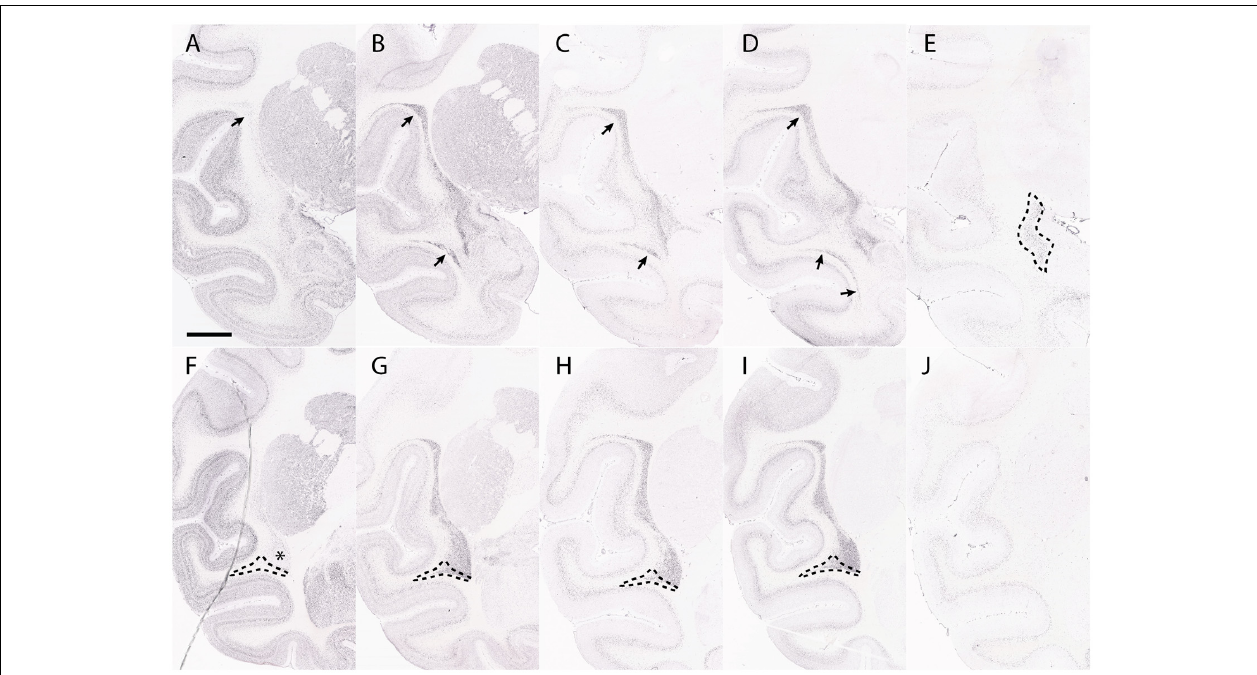
FIGURE 6 | The claustrum shows core and shell expression in the macaque. This figure shows the expression of Crym (A,F) , Synpr (B,G) , Nr4a2 (C,H) , Ntng2 (D,I) and Ctgf (E,J) in the macaque claustrum. Panels (A–E) represent sections taken at the level of anterior temporal cortex. Panels (F–J) represent sections taken caudal to the dorsal endopiriform nucleus (DEn). Crym expression forms a shell at the edges of Synpr, Nr4a2 and Ntng2 in the ventral claustrum (VCl) (asterisk, F ). The upper portion of the principal claustrum (ClP) has a more even distribution of Crym, Synpr, Nr4a2 and Ntng2 , which is homologous with the dorsal claustrum (DCl) in rodents (upper arrows, A–D ). There is a lower portion of the ClP that has weaker Synpr, Nr4a2 , and Ntng2 expression, appears outside the “shell” region of the VCl and has weak mixed Crym expression (outlined region, F–I ). These criteria, alongside the topological argument, identify this region as a continuation of the DCl traveling around and under the temporal cortex (lower arrows, B–D ; outlined region, F–I ). Panel (E) shows a selective expression of Ctgf in the DEn. The DEn appears directly caudal to the piriform cortex and disappears in further caudal sections (J) . Scale bar - 4,200 µ m. Images (A–J) © 2009 Allen Institute for